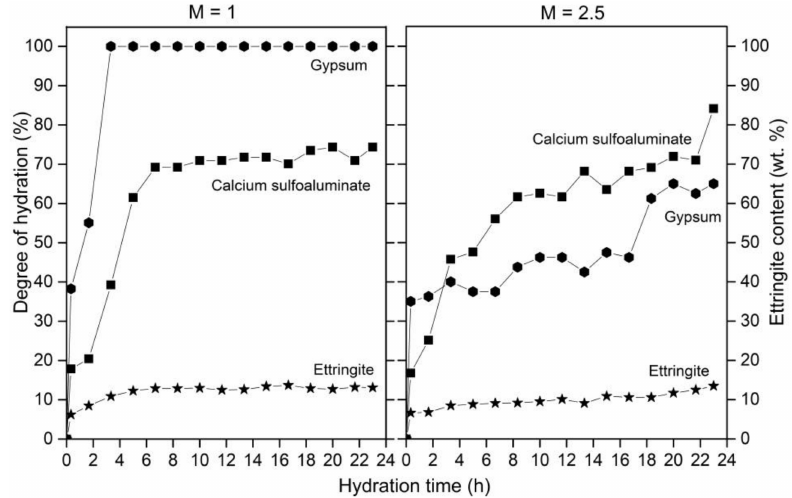
Figure 3. Degree of hydration of calcium sulfoaluminate and gypsum with ettringite content during